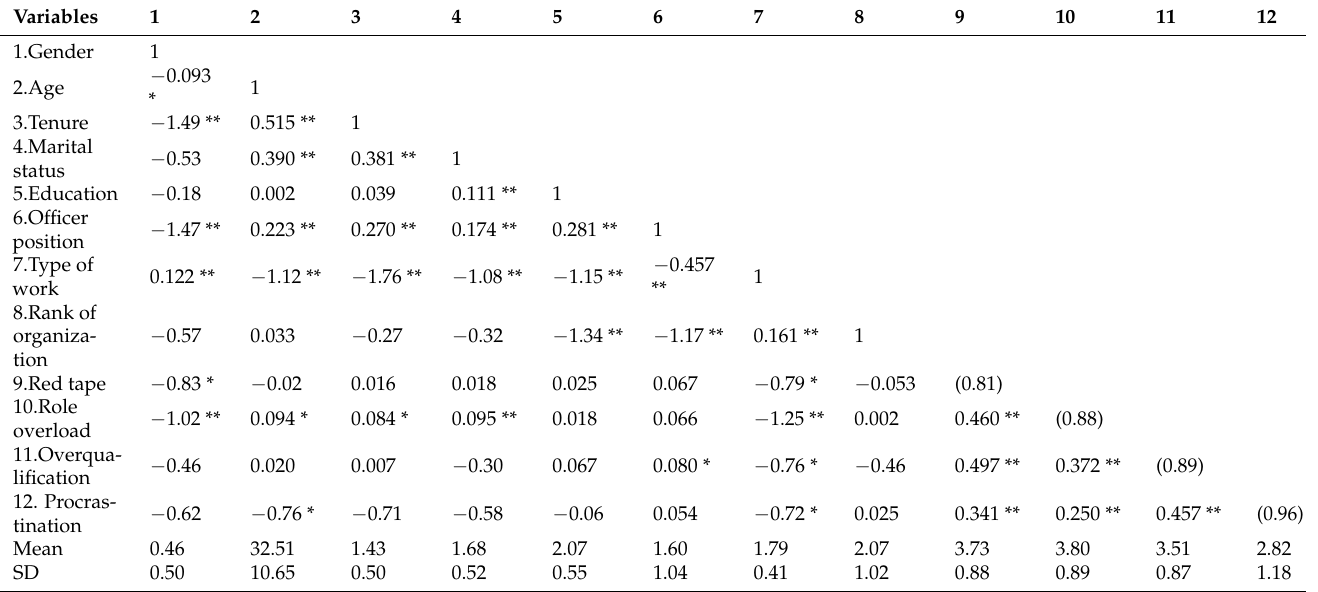
Table 2. Means, standard deviations, correlations, and reliability among the focal